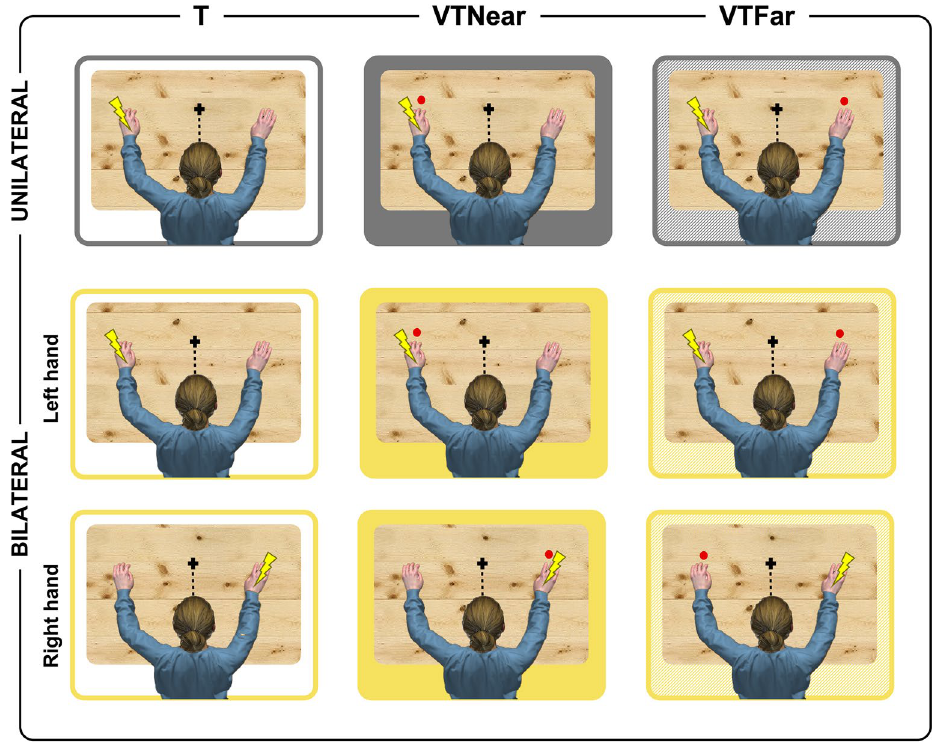
Figure 1. The figure shows a schematic representation of the experimental conditions (T, VTNear and VTFar) in the unilateral (grey) and bilateral (yellow) tasks. Red dots represent visual stimuli, while yellow thunders represent the tactile stimuli. Note that, in the bilateral task, tactile stimuli could occur either on the left or on the right hand with equal probability whereas, in the unilateral task, they always occurred on the left